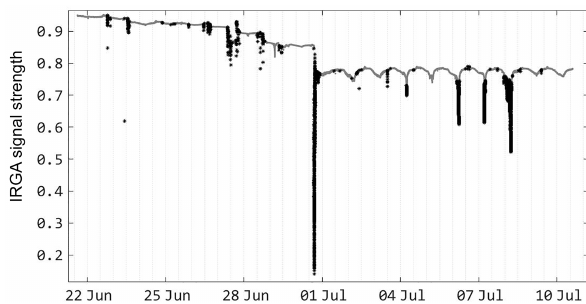
Figure 4. Time series showing data removed as spikes (bolded) from phase space criteria in Fig.